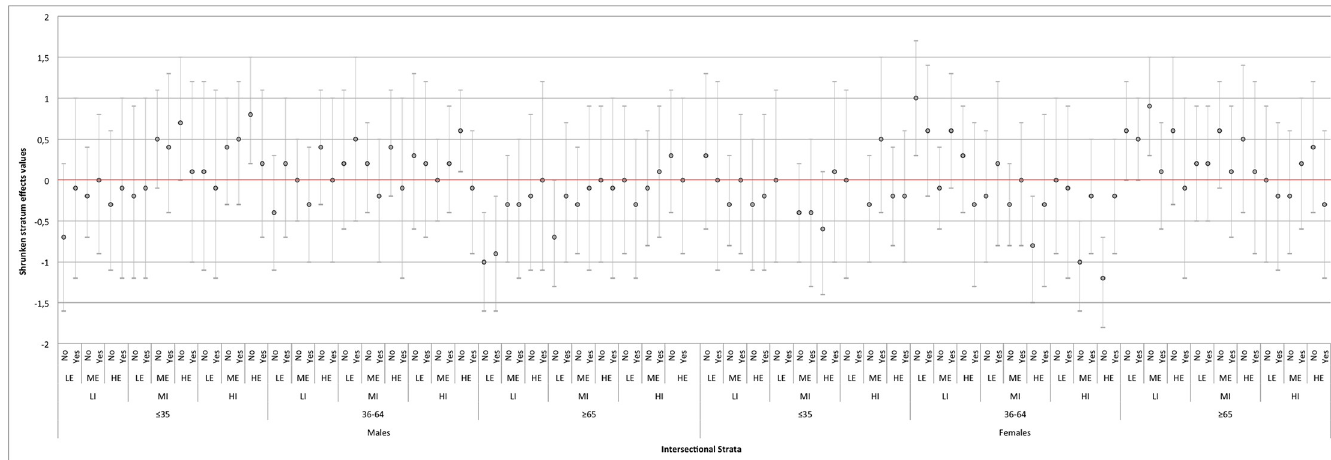
Fig 3. Differences in BMI due to interaction effects (i.e., shrunken stratum effects from the intersectional interaction model, model 2). The intersectional strata are ordered according to the demographic and socioeconomic dimensions used to define the strata. The red horizontal line at value 0 corresponds with the population average BMI. The exact values and the specific definition of the intersectional strata are indicated in the S1 Table. LI: Low Income; MI: Medium Income; HI: High Income. LE: Low Education; ME: Medium Education; HE: High Education.